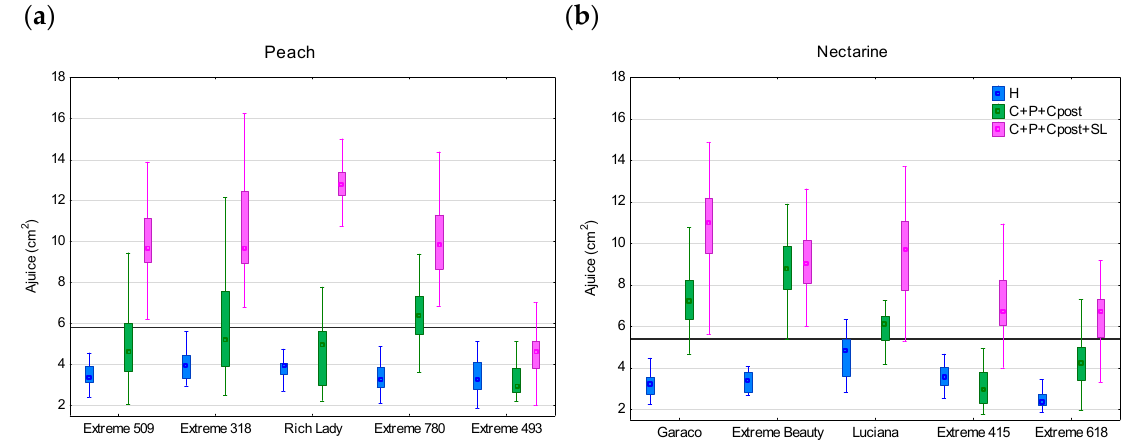
Figure 4. Box-and-whiskers plot of the instrumental juiciness (Ajuice) of the fruits of the 2019 season categorized according to the postharvest protocol for peaches ( a ) and the nectarines ( b ). The black lines indicate the instrumental juiciness limits (10th percentile). H (one day after harvest), C (cold storage), P (pre-ripening), Cpost (cold storage post pre-ripening), and SL (shelf life).